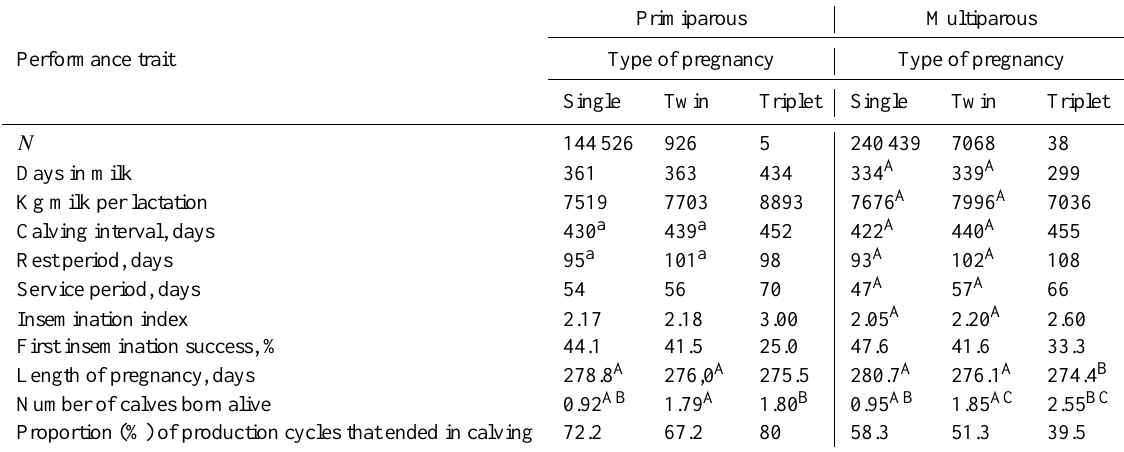
Table 2. Milk and reproductive performance of primiparous and multiparous cows in a productive cycle after giving birth to single, twin, and triplet calves.